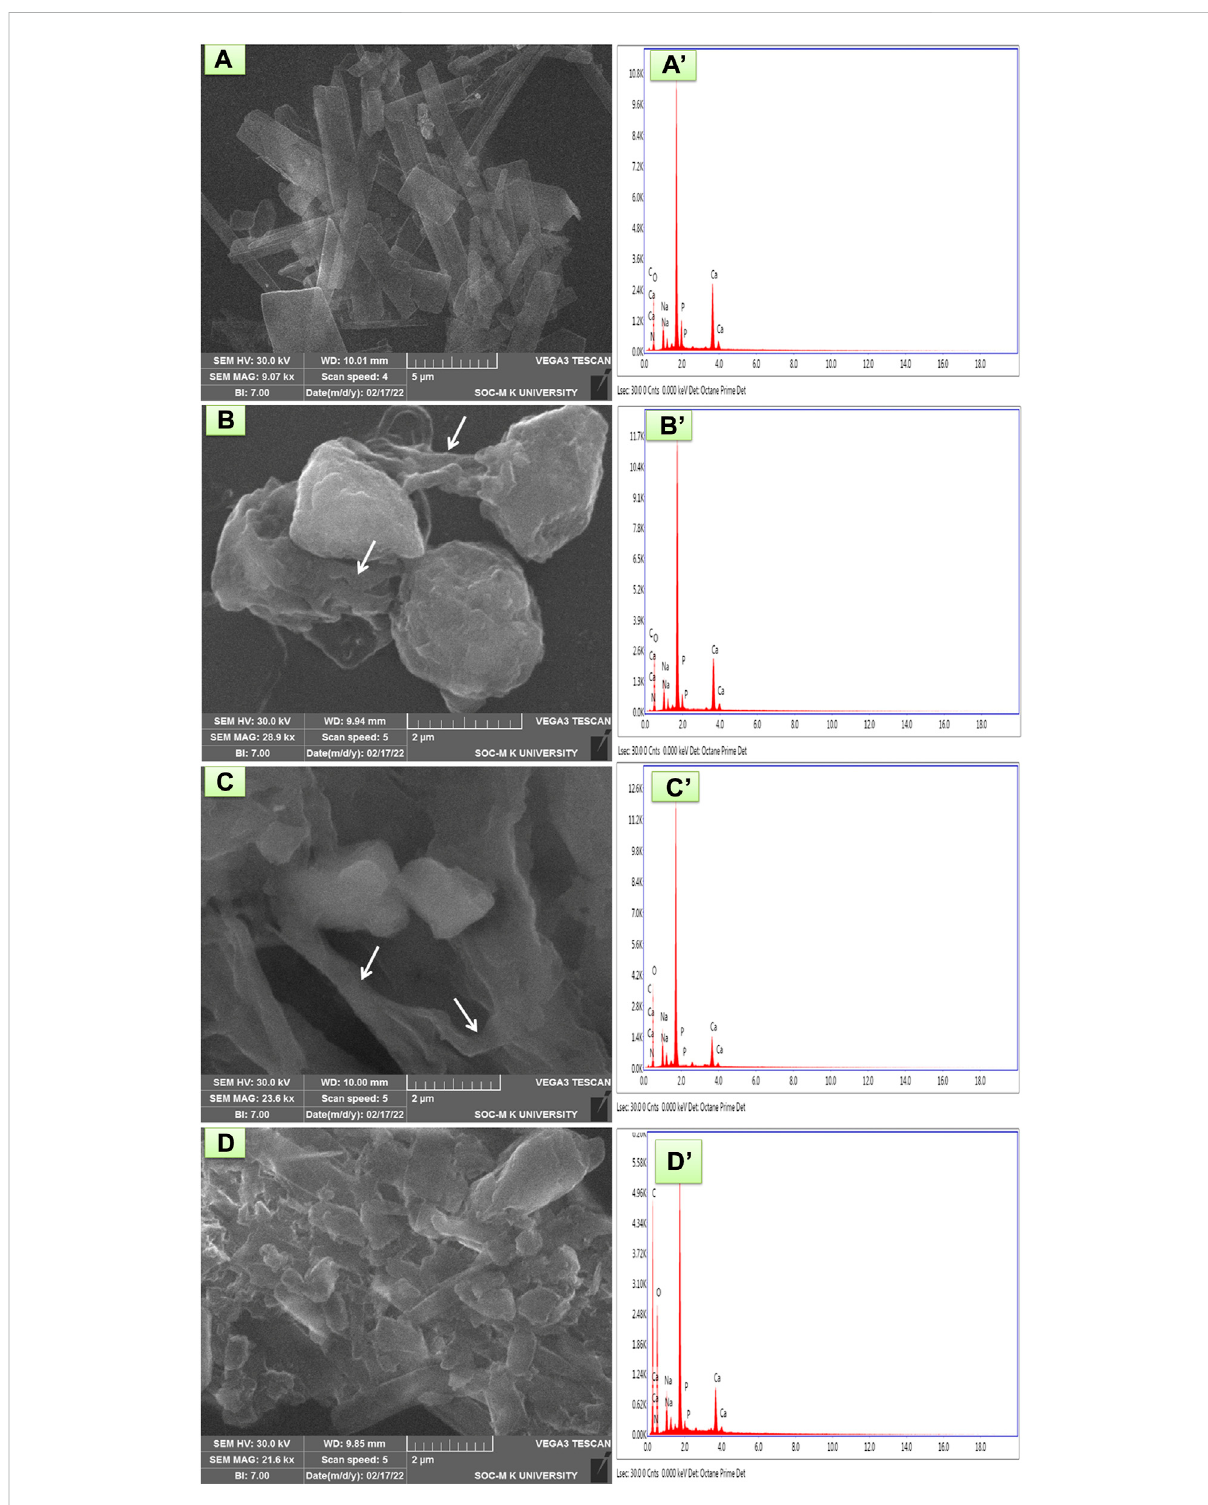
FIGURE 3 SEM and EDX analysis of (A and A 9 ) HAP ceramic (B and B 9 ) HAP/COL composite, (C and C 9 ) HAP/COL/CCQD composite, and (D and D 9 ) HAP/ COL/CCQD/CRN